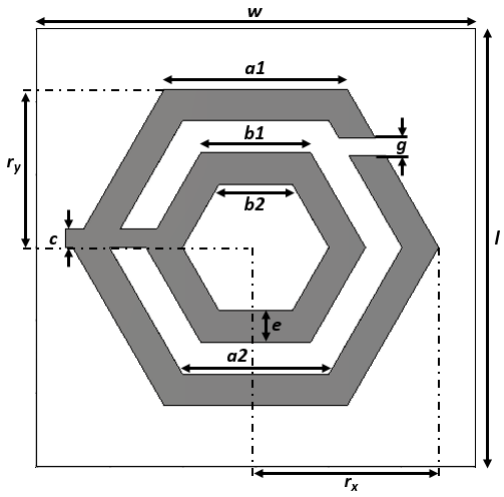
Figure 1. Proposed hexagonal split-ring resonator (HSRR) structure of the unit cell.